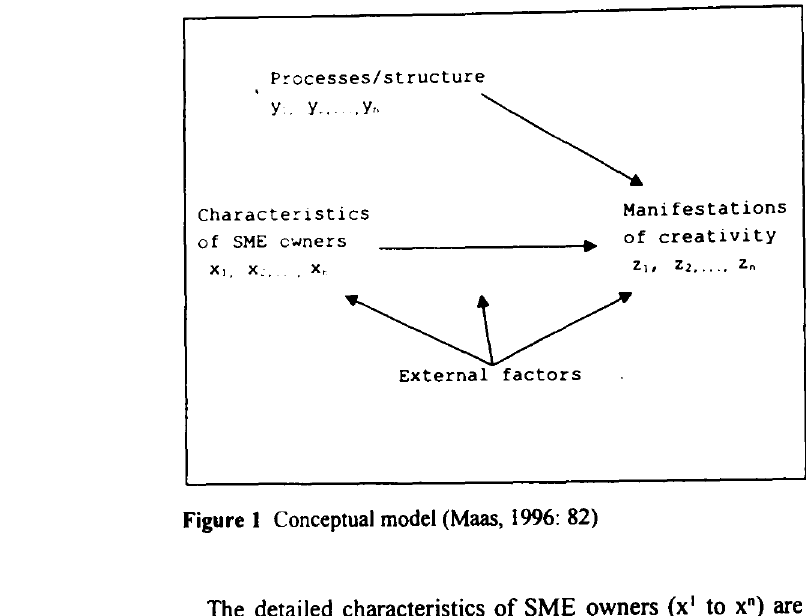
The detailed characteristics of SME owners (x 1 to x") are outlined in Part A, Annexure A; processes and structures of SMEs (y' toy") in Part B, Annexure A; and manifestations of creativity (z' to Z") in Part C, Annexure